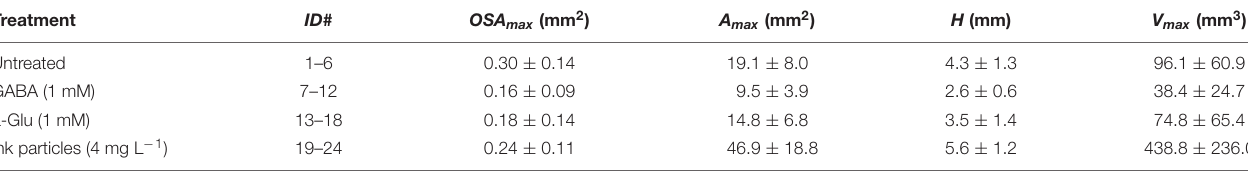
TABLE 1 | Halichondria panicea . Dimensions of (expanded) sponge explants before exposure to different treatments. Treatment